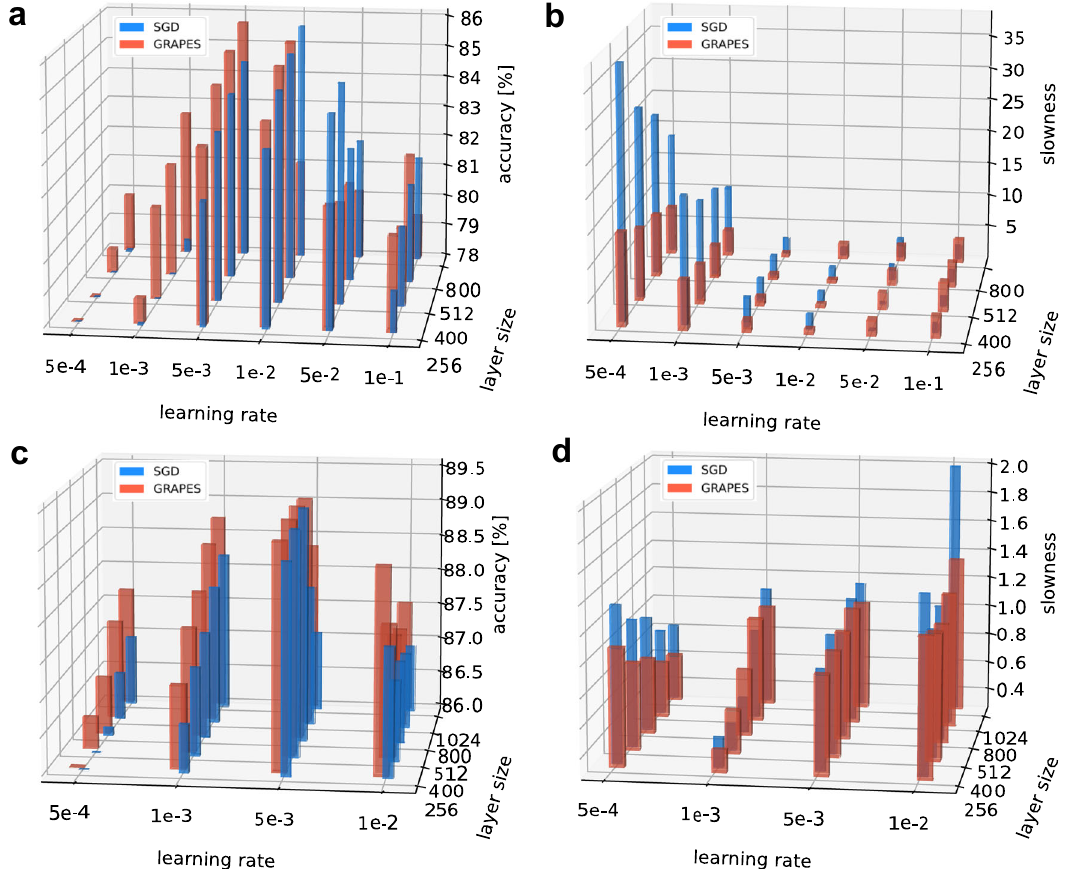
Fig. 5 GRAPES applied to FA and DFA on Extended and Fashion MNIST. Test accuracy and convergence rate in terms of slowness value for three-hidden layer ReLU networks, with 10% dropout, trained with FA on the Extended MNIST and DFA on the Fashion MNIST dataset, as a function of the layer size and the learning rate. The slowness parameter is computed by fi tting the initial 100 epochs. The accuracy for each run is computed as the mean of the test accuracy over the last 10 training epochs. The reported result is the mean over the accuracy of ten independent runs. a Test accuracy and b convergence rate for FA on Extended MNIST. c Test accuracy and d convergence rate for DFA on Fashion MNIST. For visualization purposes, the bases of the SGD and GRAPES bars are slightly shifted from each other. The actual learning rates and layer sizes are the same for both and are reported in the axes' labels. Table 1 Test accuracy on the CIFAR-10 and CIFAR-100 datasets for CNNs trained with BP and Adam, with and without GRAPES modulation.